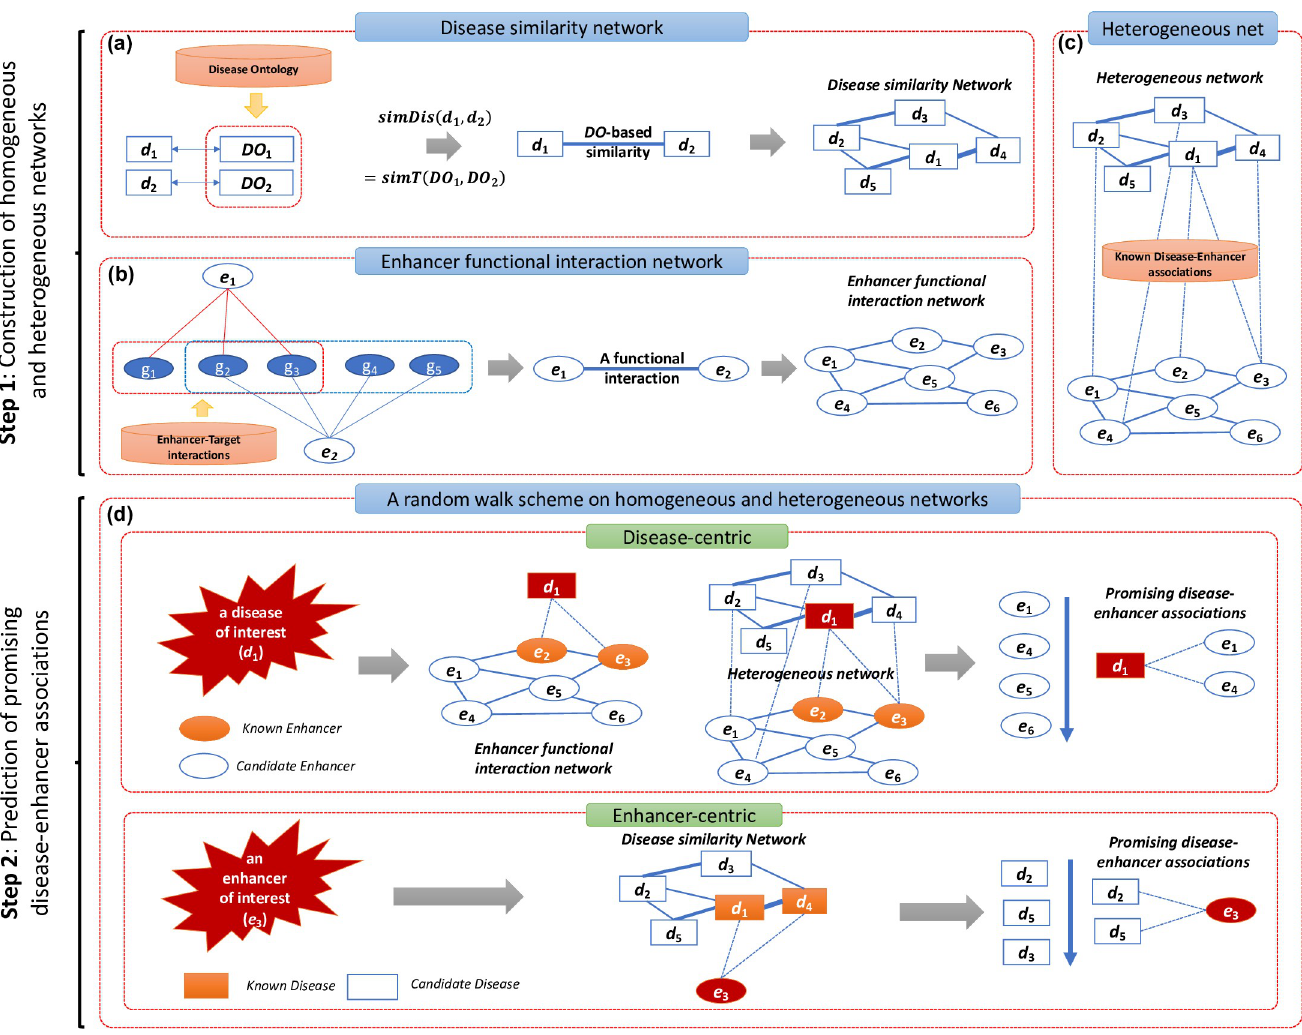
Fig 1. Illustration of RWDisEnh method. RWDisEnh includes two main steps. Step 1—Construction of homogeneous and heterogeneous networks : (a) A disease similarity network was formed based on DO-based similarities between every pair of mapped DO terms. (b) An enhancer functional interaction network was constructed by connecting every pair of enhancers significantly sharing target genes. (c) A heterogeneous network of diseases and enhancers was built by connecting the enhancer functional interaction network, the disease similarity network, and known disease-enhancer associations. Step 2—Prediction of promising disease- enhancer associations : (d) A random walk model was proposed on the networks to rank candidate enhancers/diseases. For disease-centric view: Given a disease d 1 , the goal is to rank all candidate enhancers ( e 1 , e 4 , e 5 , and e 6 ) by their relevance to d 1 . For enhancer-centric view: Given an enhancer e 3 , the goal is to rank all candidate diseases ( d 2 , d 3 , and d 5 ) by their relevance to e 3 . Finally, highly ranked candidates (e.g., e 1 , e 4 for the disease-centric, and d 2 , d 5 for the enhancer-centric) were selected as promising ones to be associated with the disease of interest ( d 1 )/the enhancer of interest ( e 3 ), respectively.